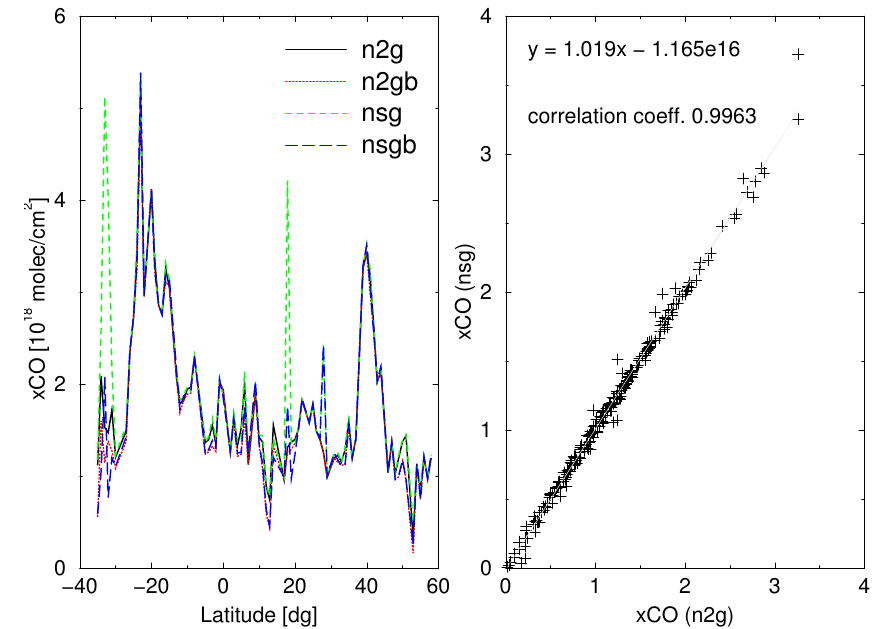
Fig. 11. Sensitivity of CO retrievals with respect to least squares algorithm for orbit 8663 (27 October 2003, covering Russia, the Arabic peninsula, and Eastern Africa): (a) comparison of CH 4 -normalized CO vertical columns (xCO). “n2g” and “nsg” denote nonlinear and separable least squares, respectively; “b” indicates the bound constrained versions. (b) Scatter plot of xCO retrieved using nonlinear least squares (“n2g”, horizontal axis) vs. separable least squares (“nsg”, vertical axis). Table 1. Cross correlation coefficients ρ between fit parameters and throughput. 32 parameter CO CH 4 H 2 O correlation with throughput